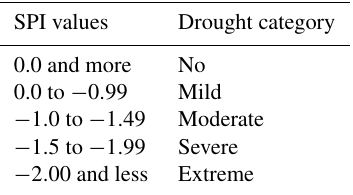
Table 1. Drought intensity categories based on SPI values